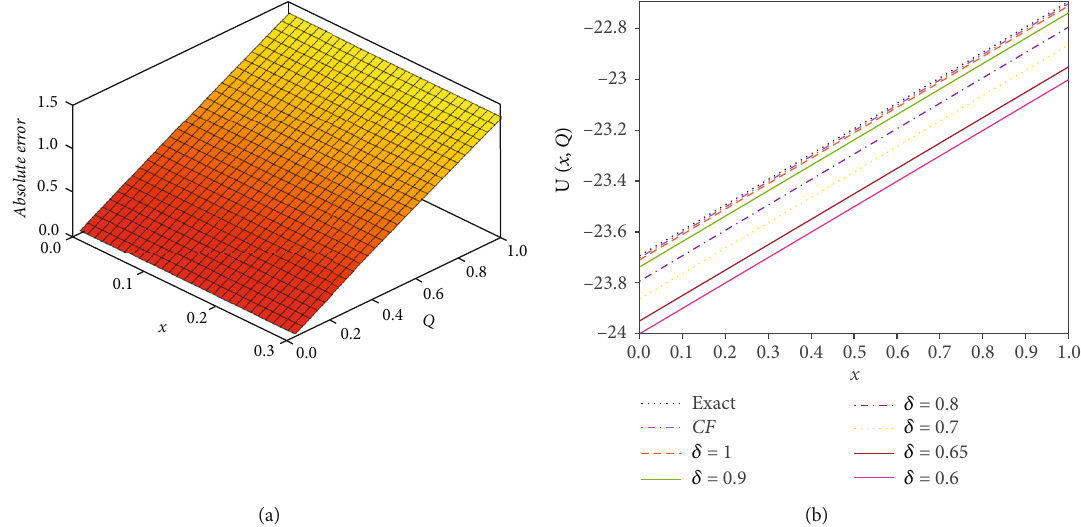
Figure 6: Three-dimensional illustration via the CFD of Example 1. (a) Absolute error. (b) Multiple